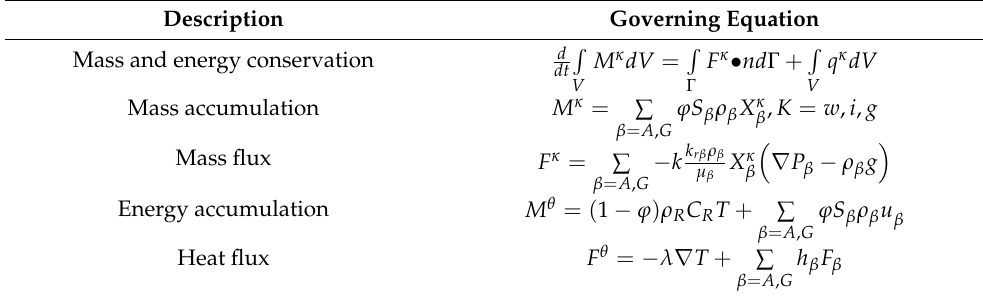
Table 1. General mathematical model of coupled TH processes in TOUGH2 V2.0.